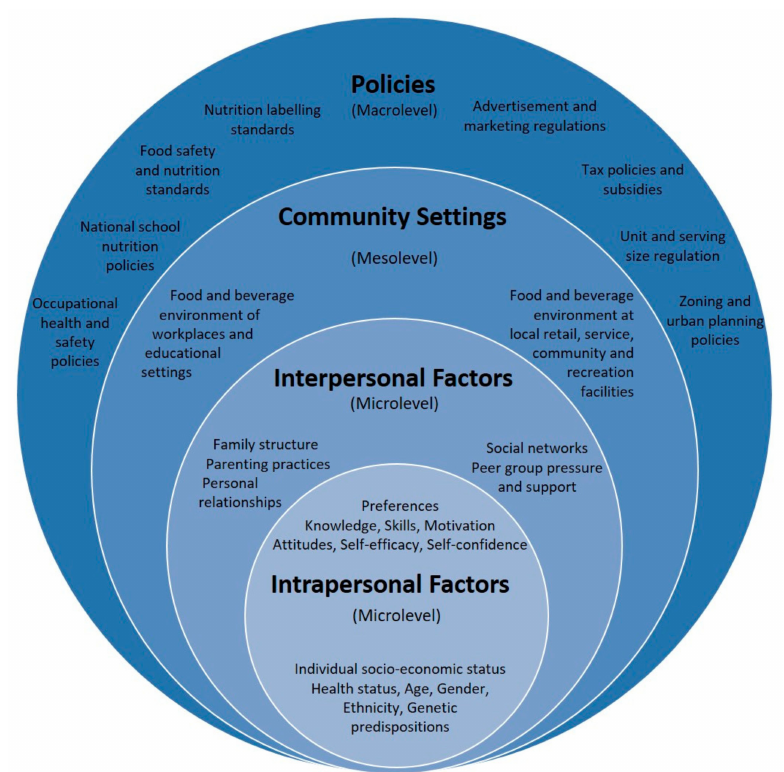
Figure 3. Socio-ecological model of food and beverage intake. Originally printed in [75]. Reprinted with permission from Ludwig-Maximilians-Universität,